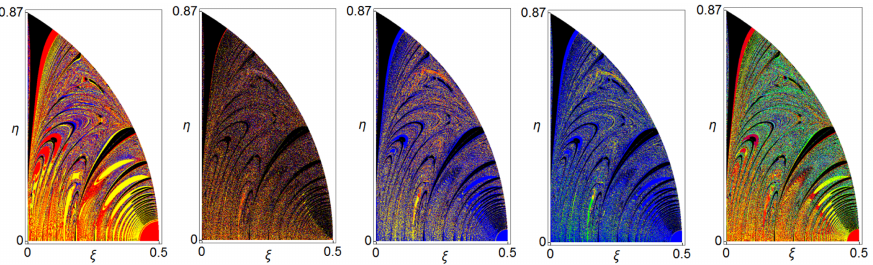
Fig. 5. Left to right: 20 th symbol in the sequences for Method bin and Method triple, 40 th symbol for Methods 3, 4 and D. Black color corresponds to short-lived